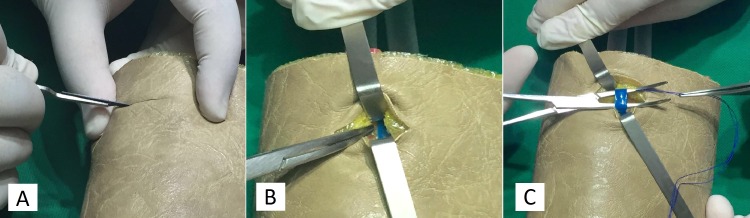
Training vascular accesses: (A) Achieving access route in the skin; (B) Exposure of adjacent tissues; (C) Identification of blood vessel and its blue liquid content, representing the venous system of the forearm.